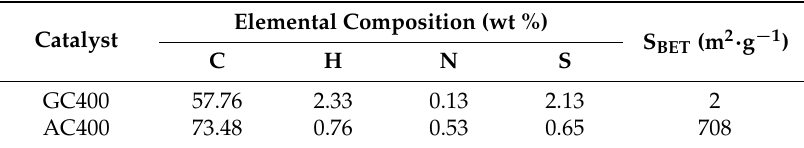
Table 1. The results of CHNS elemental analysis and surface